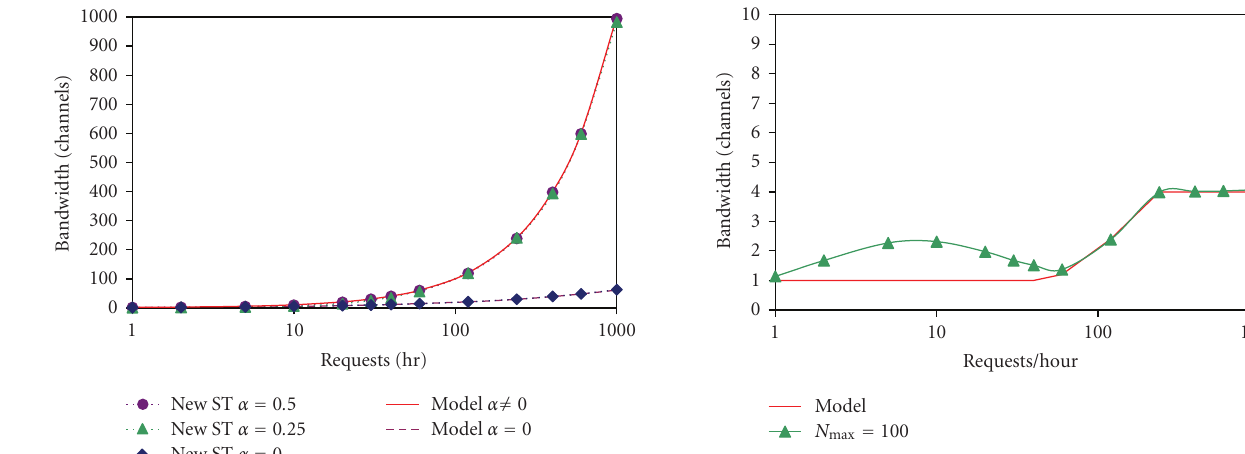
Figure 10: Server bandwidth requirements of the protocol for α = 0.25, β max = 0.25, and N max =